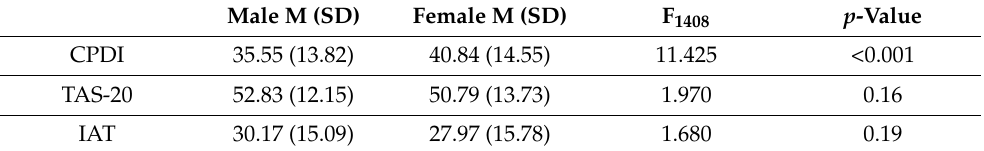
Table 3. Univariate results of differences between male and female scores on CDPI, TAS-20, and IAT. Male M